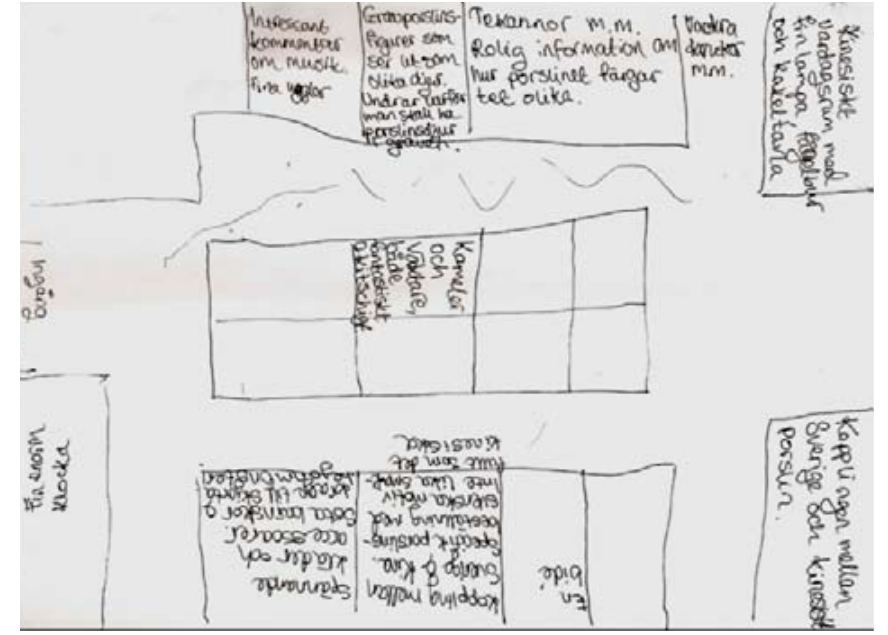
Fig 3. Bridget’s ‘map’ of the